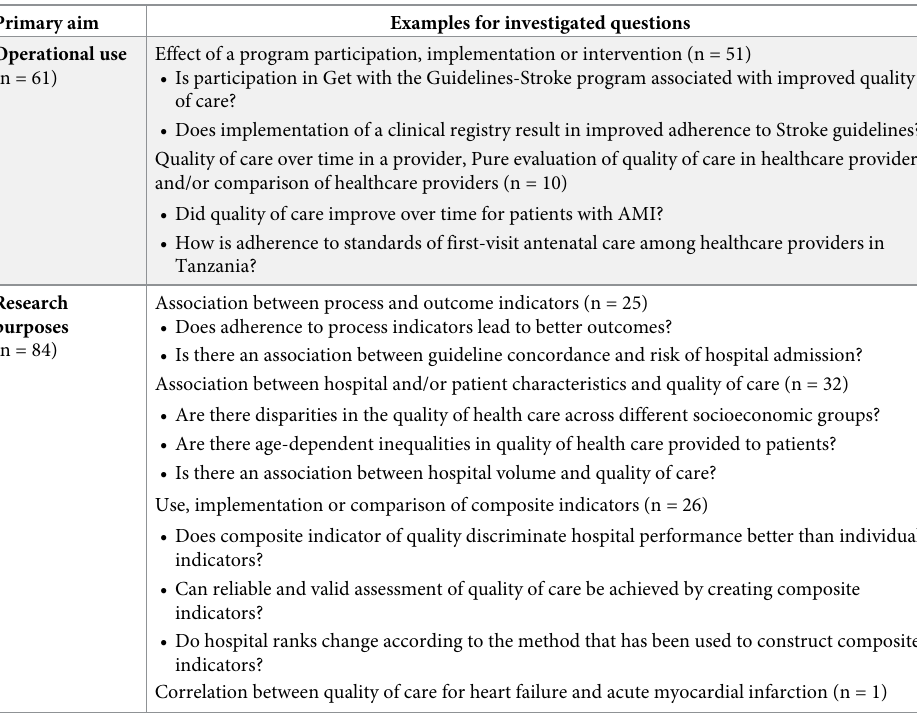
Table 3. Examples for investigated questions in included